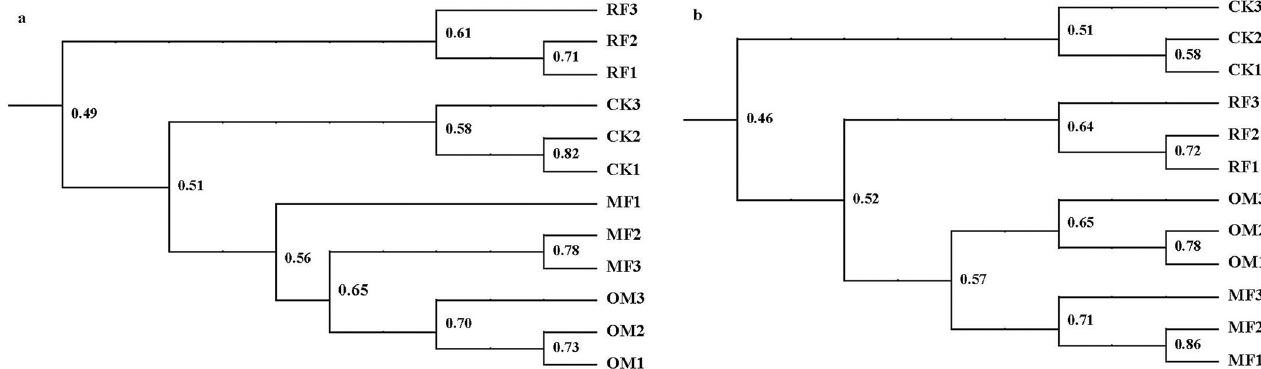
Fig 2. Similarity dendrograms (UPGMA, Dice coefficient of similarity) analysis of cbbL R gene (a) and nifH gene (b) with different long-term fertilizer treatments.